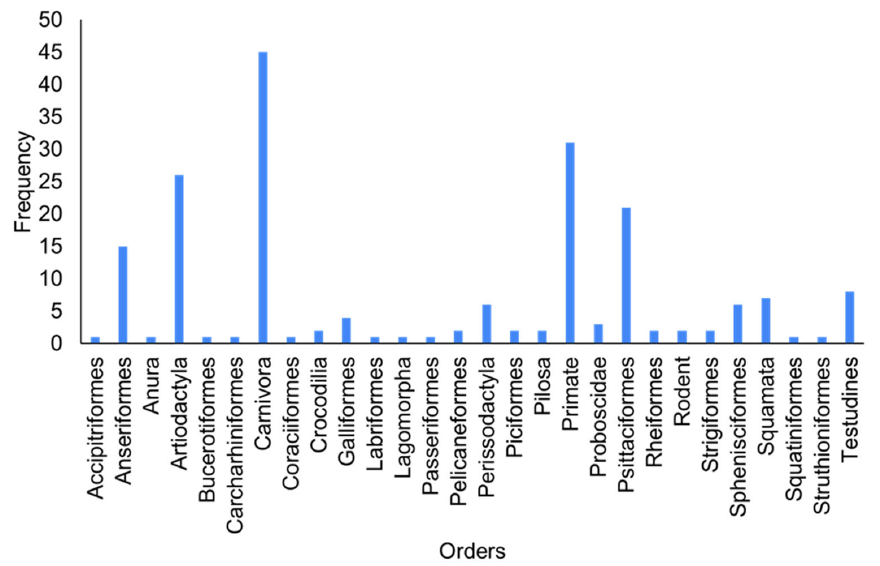
Figure 1. Overview of the frequency of orders being reported in BIAZA-accredited zoos’ Facebook pages.